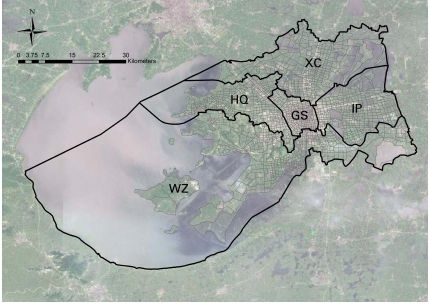
Figure 1. Diagram of the study area